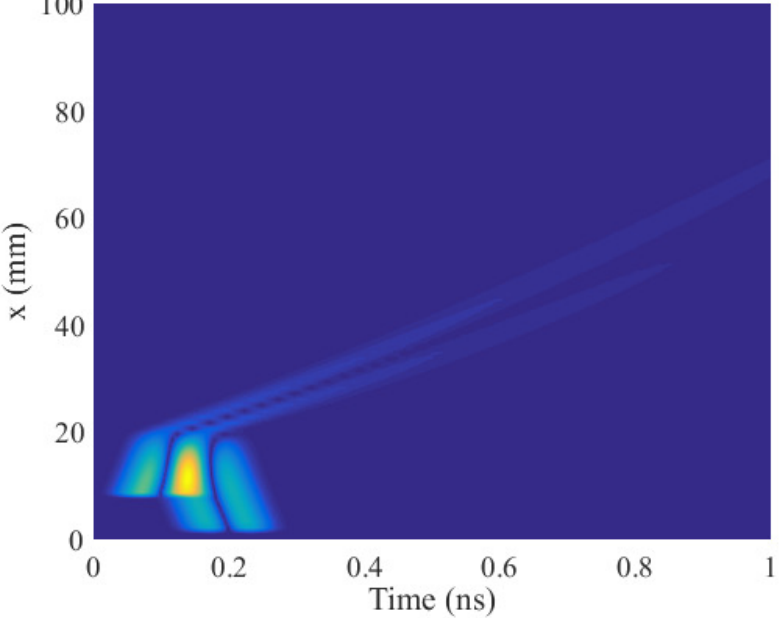
Figure 4. Space-time electric field distribution inside a dispersive media modeled by a Maxwell– Garnet relationship characterized by an exponential filling factor function. Reproduced under the terms of a Creative Commons Attribution 4.0 International License [86]. Copyright 2016, The Authors, published by Hindawi Ltd.